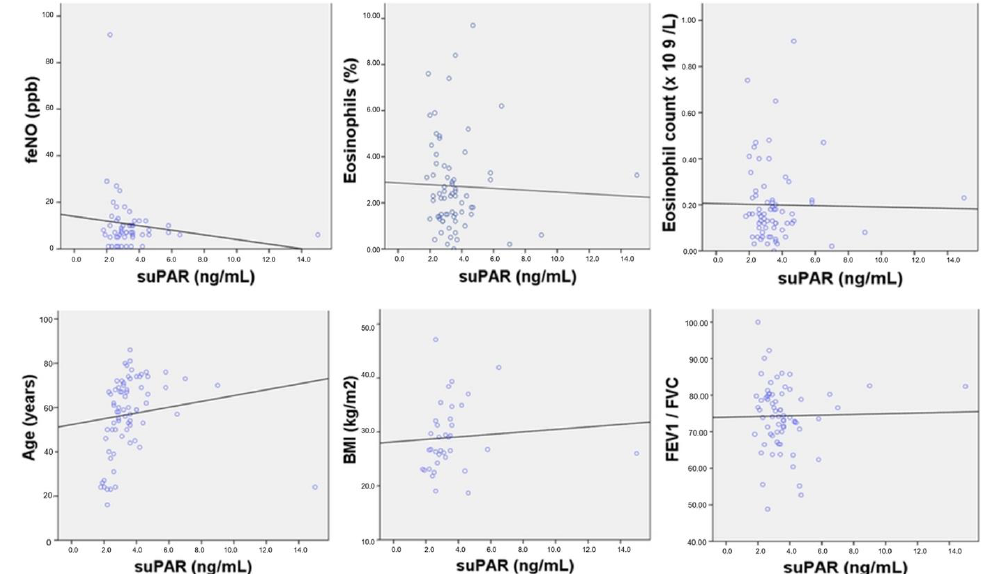
Figure 3. Correlation analysis between suPAR levels and age, body mass index (BMI), T2 biomarkers, and forced expiratory volume in the first second (FEV1)/ forced vital capacity (FVC). Note: No correlation was found between suPAR levels and fractional exhaled nitric oxide (FeNO) (r = − 0.014, p = 0.308), eosinophils % (r = − 0.037, p = 0.767), eosinophil count (r = − 0.016, p = 0.895), age (r = 0.14, p = 0.238), BMI (r = 0.079, p = 0.646)), and FeV1/FVC (r = 0.020, p = 0.870). Abbreviations: BMI, body mass index; FeNO, fractional exhaled nitric oxide; FeV1/FVC, forced expiratory volume in the first second/forced vital